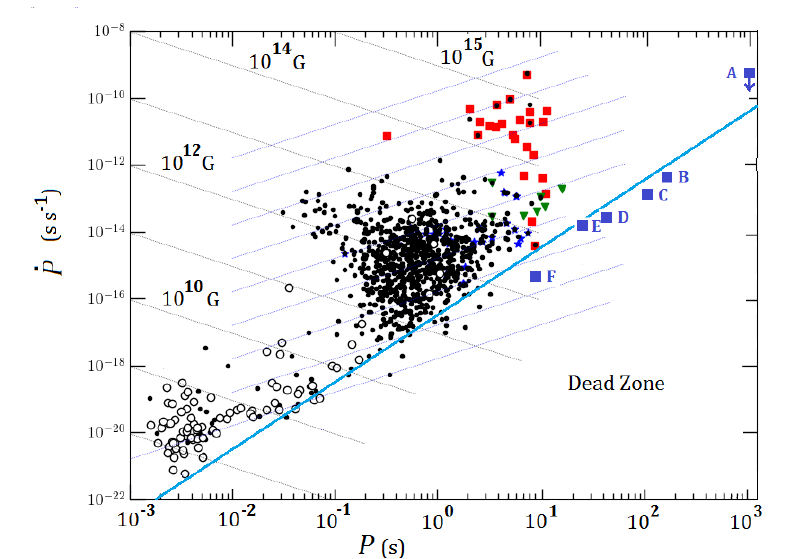
Figure 1. The P − ˙ P diagram with the new objects. The diagram had to be extended up to periods of ∼ 10 3 s to accommodate the ultra-long period magnetar candidates. The symbols are as follows: ordinary pulsars (black dots), millisecond and binary pulsars (open circles), XDINSs (green triangles), RRATs (blue stars), Magnetars (red squares), and the new objects in blue squares. (A) GLEAM-X 162759.5-523504.3 [12], (B) AR Scorpii [43], (C) J0901-4046 [44], (D) J0250+5884 [45], (E) J2251-3711 [46], (F) J2144-3933